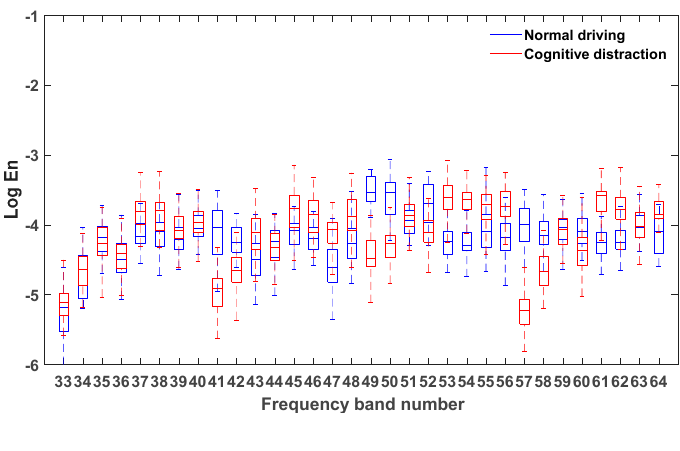
ff erent driving